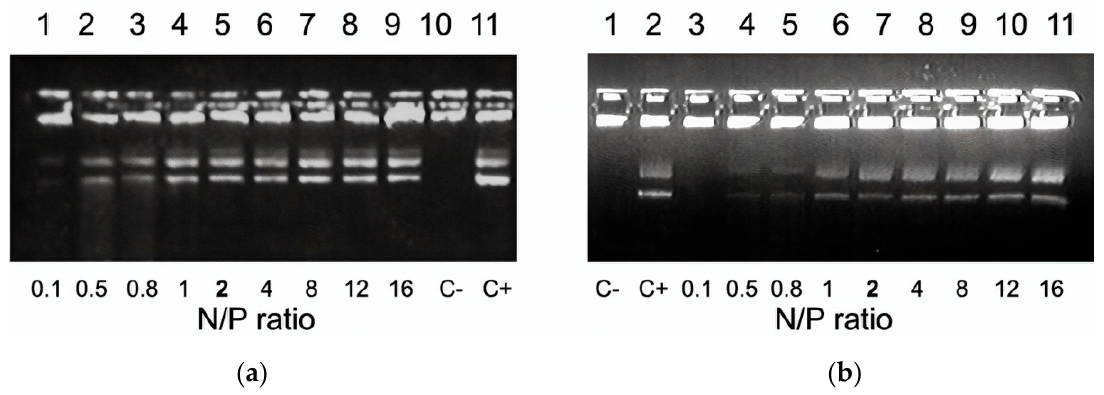
Figure 2. DNase I protection assay of DNA-complexes formed with ( a )RGD1-R6 and ( b )RGD0-R6 carriers. N/P ratio in bold indicates the beginning of DNA protection. C–, ‘naked’ plasmid DNA treated with DNase I, C+, untreated plasmid DNA.